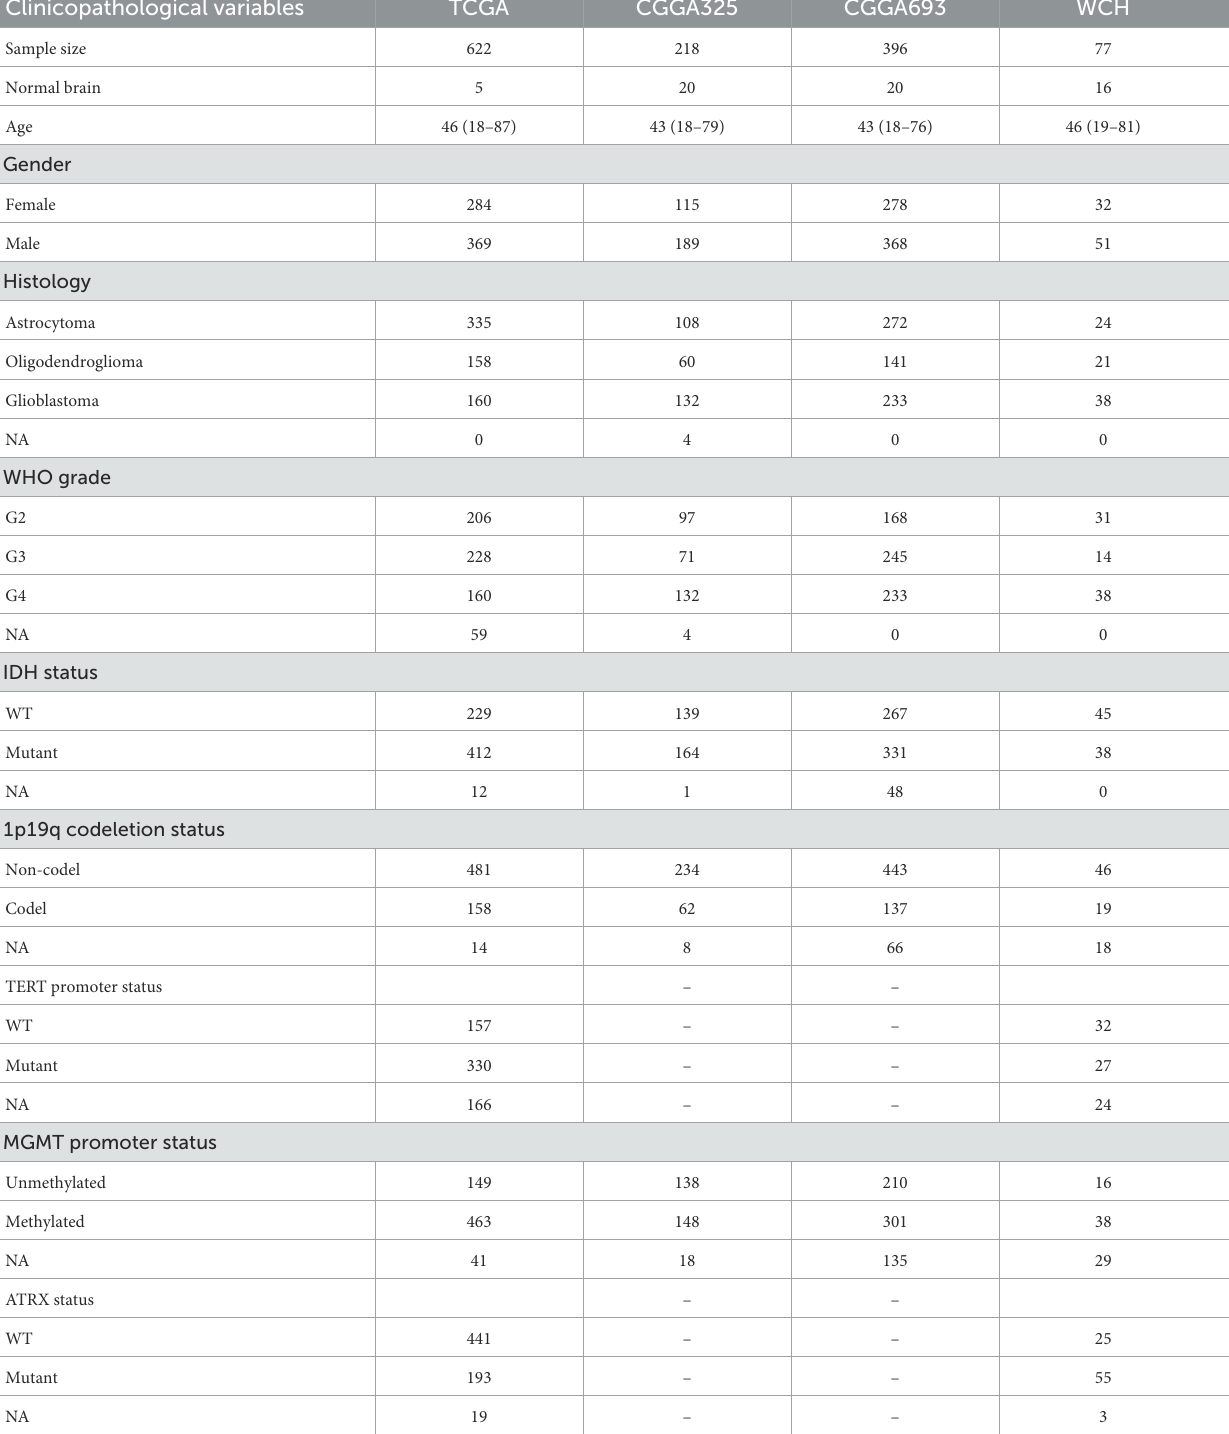
TABLE 1 Clinicopathological characteristics of patients with diffuse glioma in the TCGA, CCGA, and WCH cohort. Clinicopathological